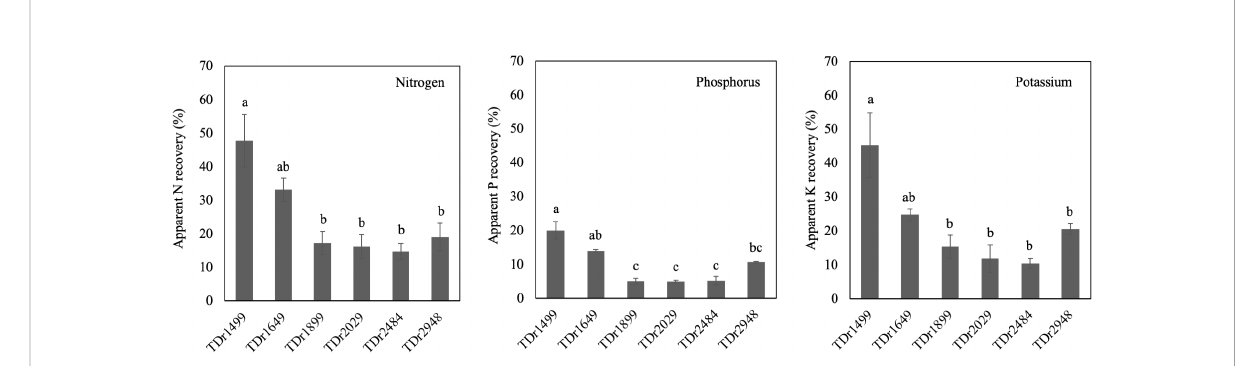
FIGURE 3 Apparent nutrient recovery ef fi ciency of six genotypes in white Guinea yam ( Dioscorea rotundata ). Nitrogen (left box), phosphorus (centre box), and potassium physiological ef fi ciency (right box) are shown. All values are expressed as means. Different alphabet indicates statistical signi fi cance ( P < 0.05). Bars represent presents a standard